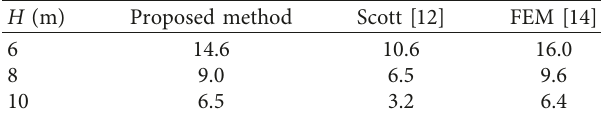
Table 2: Calculated results.